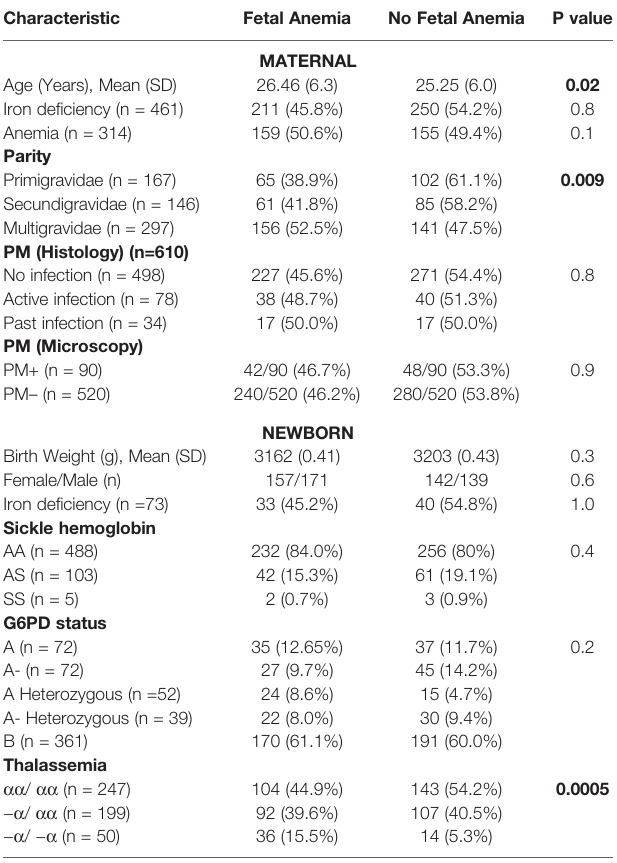
All variables were analyzed by Chi-square t-test except for maternal age and birth weight (unpaired t-test). Bold values represent signi fi cant